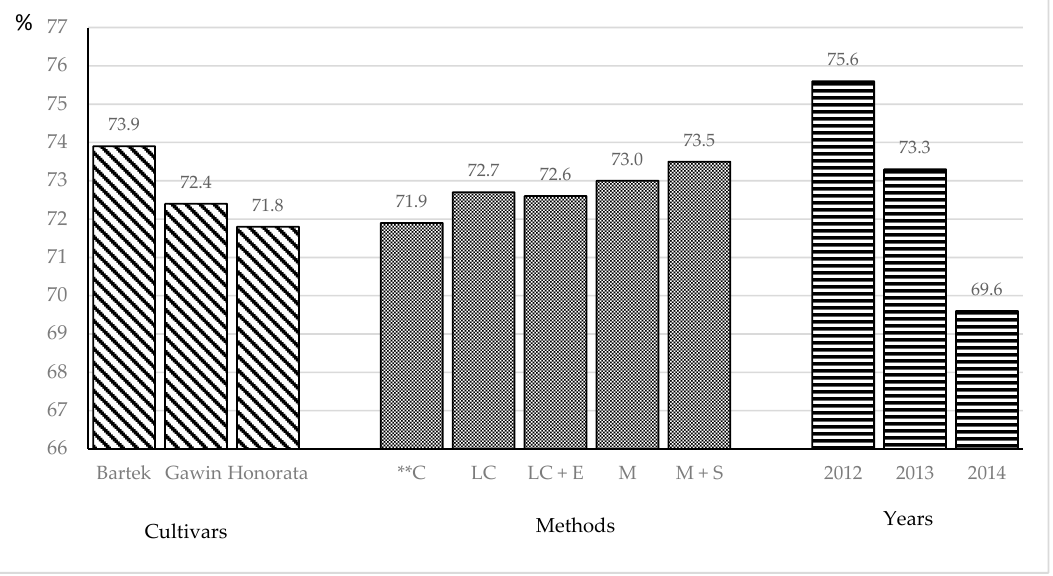
Figure 1. Percentage of true protein in potato tubers total protein. ** C—Control object; LC - linuron + clomazone; LC + E - linuron + clomazone + Ecklonia maxima; M—metribuzin; M + S—metribuzin +